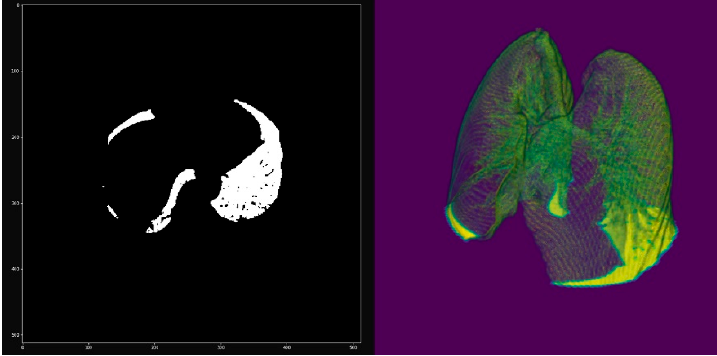
Figure 8. Non-definitive mask without stretcher: 2D slice ( left ) and 3D volume ( right ).